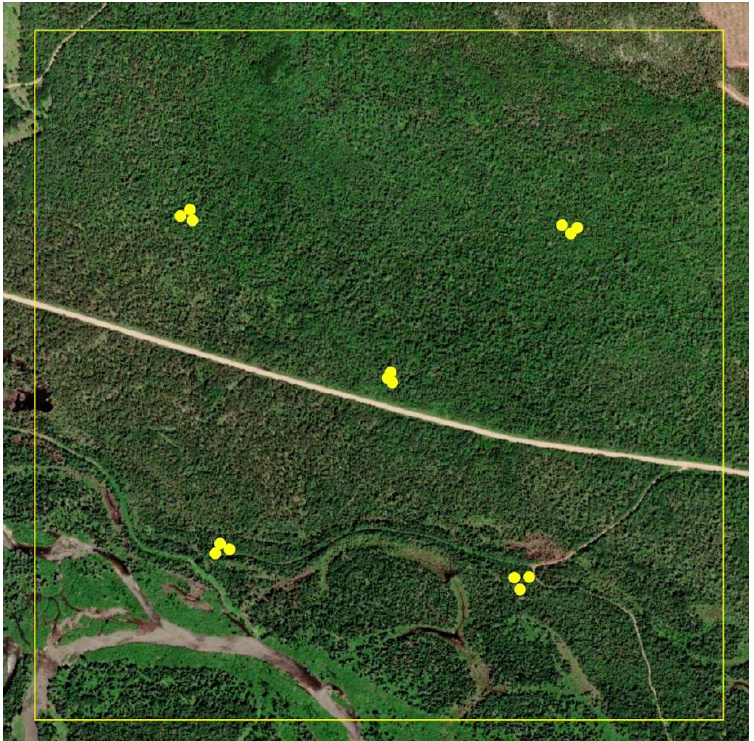
Figure 2. Placement of pheromone traps in 5 clusters of 3 traps each within 300 ha study Block 2, as example. Traps within clusters were spaced 30 m apart.